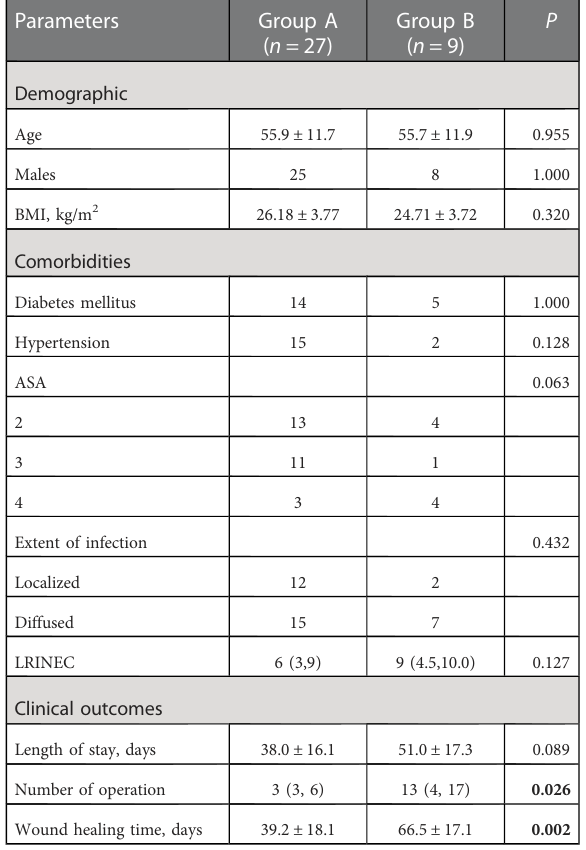
TABLE 3 Comparison of clinical characteristics and outcomes between two groups.